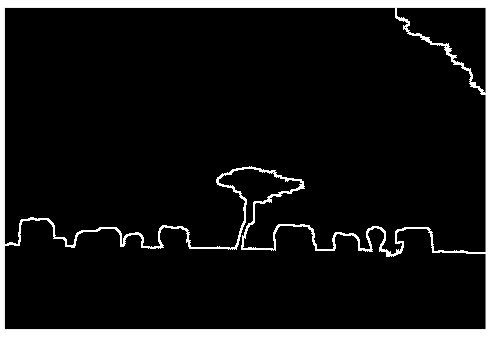
Figure 3. Boolean matrix of image #253036 from BSDS under optimal threshold.